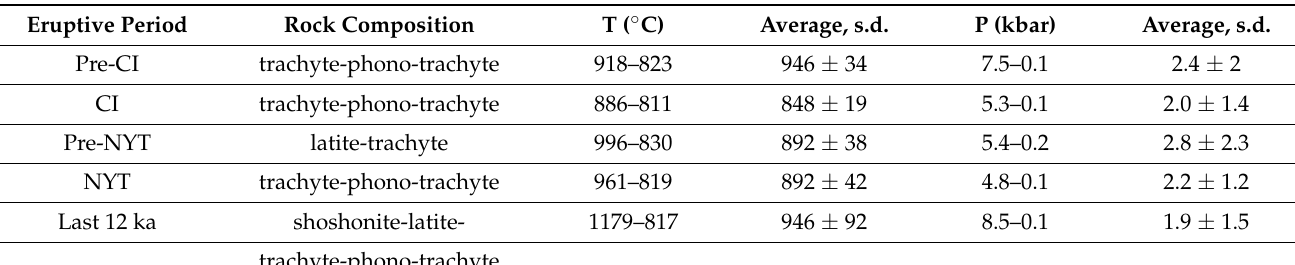
Table 5. Temperature and pressure output obtained from the Putirka [13] geothermobarometers applied to clinopyroxene-melt couples whose equilibrium has been verified with the equilibrium test 2.